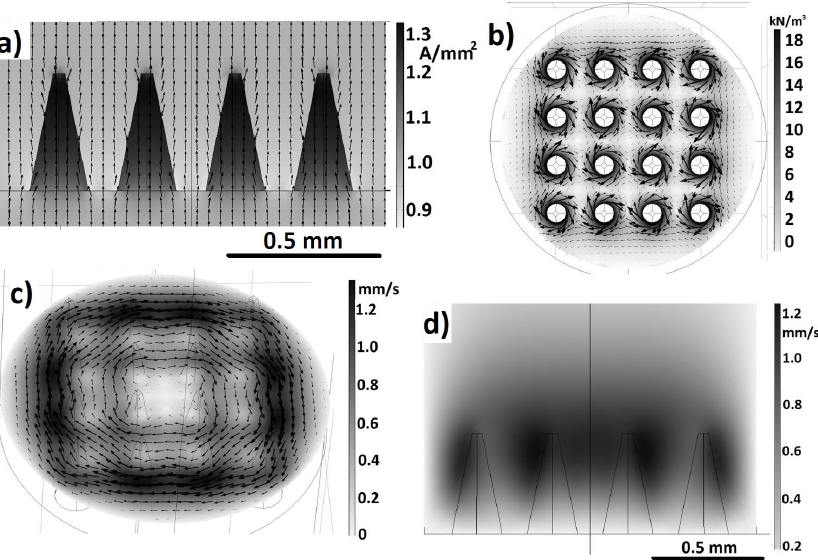
Figure 4. Numerical simulation results of melt flow in mushy zone: a) Electric current distribution; b) Lorentz force distribution at the middle height; c) Velocity distribution at the middle height; d) Velocity magnitude distribution at the vertical